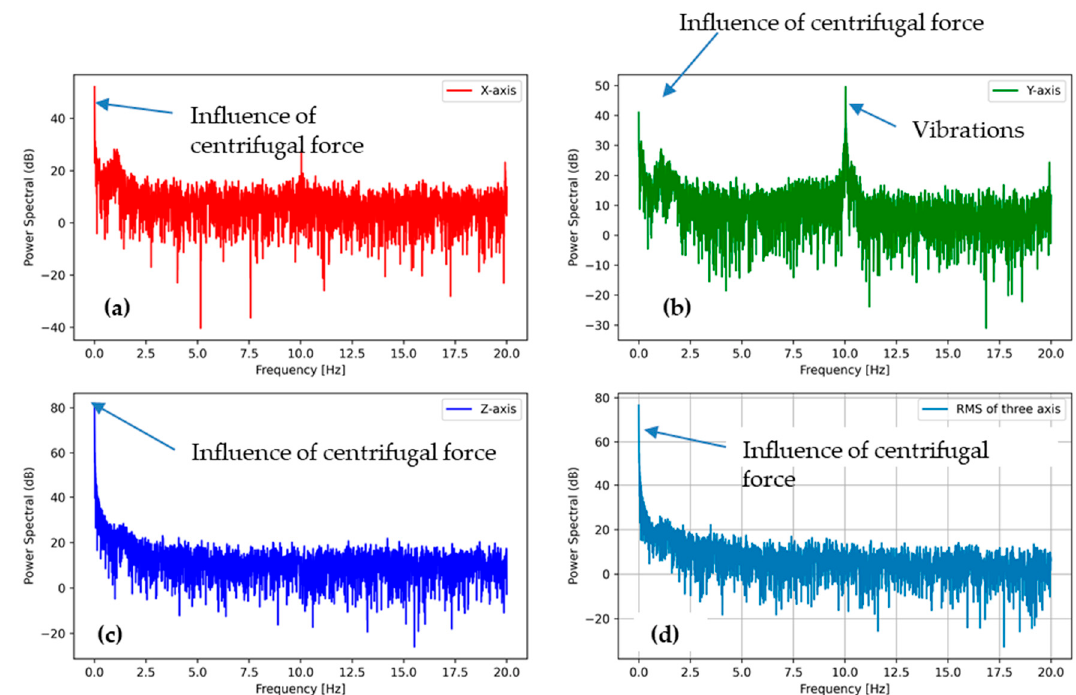
Figure 12. PSD of the accelerometer outputs from tumble phase (600 RPM) ( a ) in the X direction, ( b ) in the Y direction, and ( c ) in the Z direction, ( d ) the sum of all the accelerations.